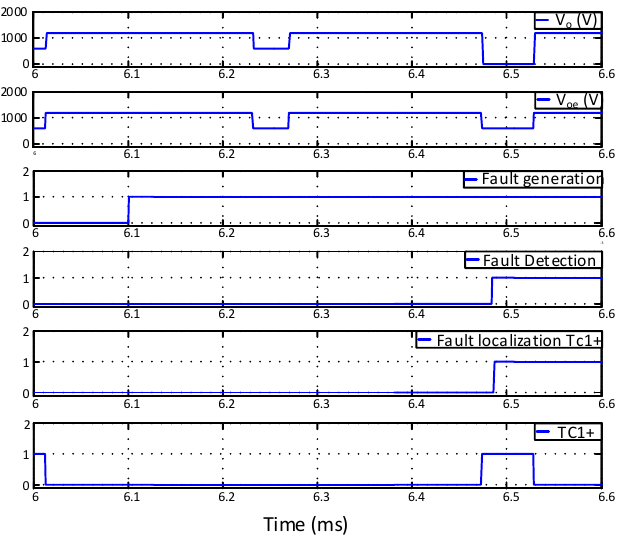
Fig. 8 Zoomed simulation results when Tc1+ is faulty (OCF).